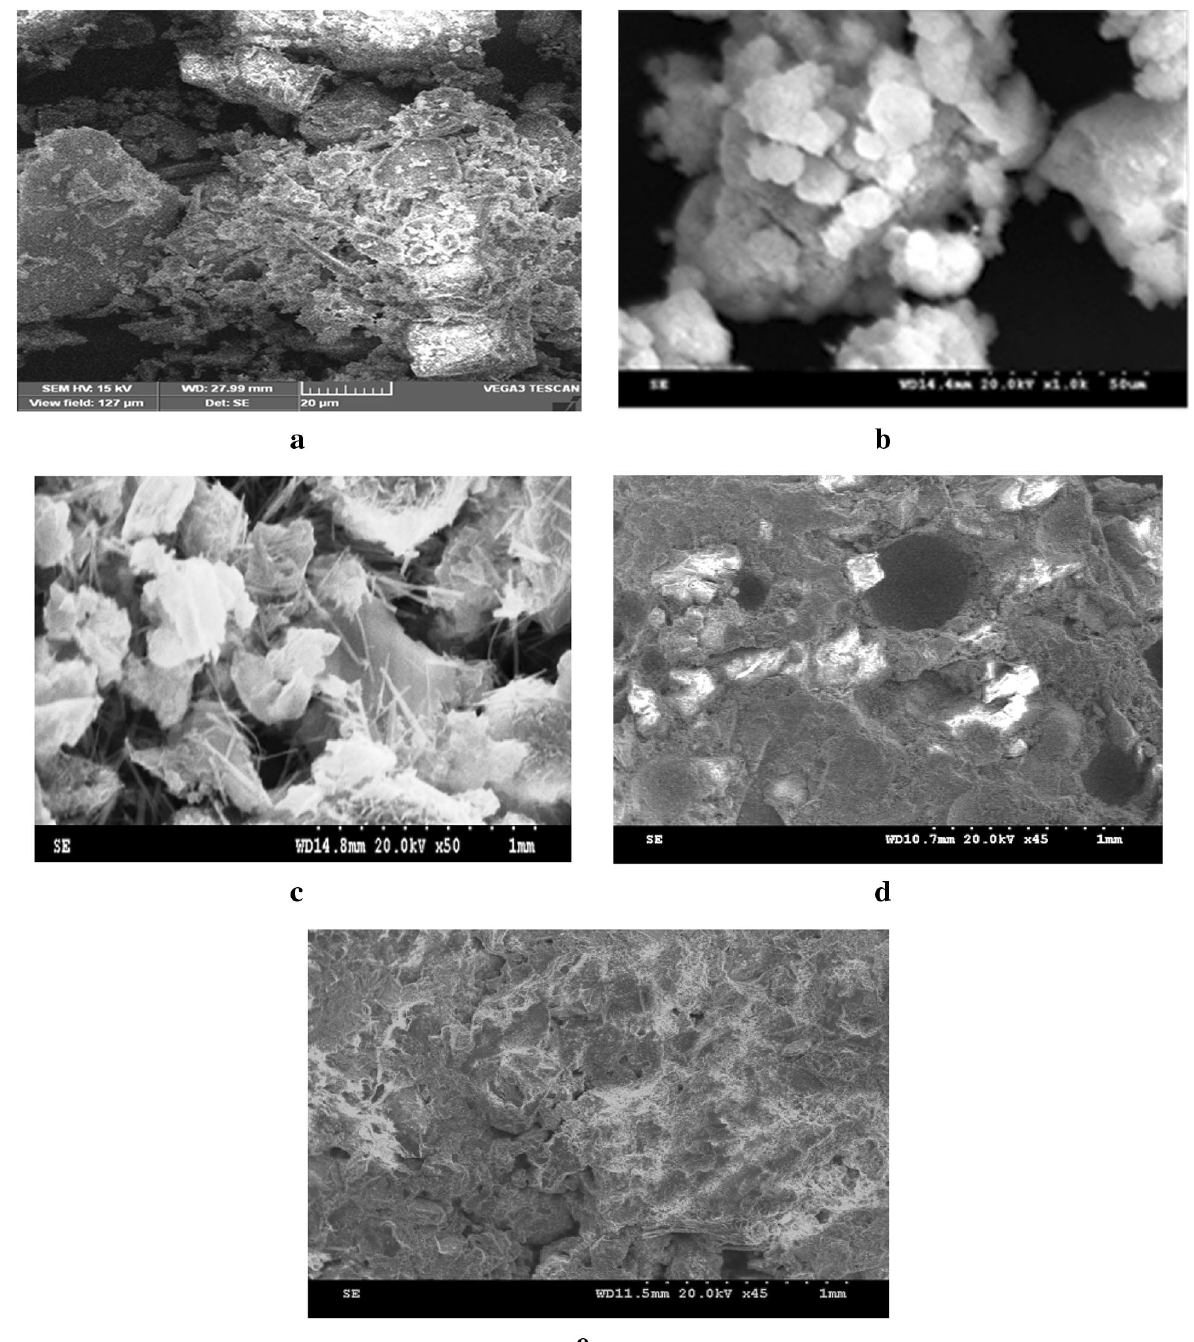
Fig. 2 a Morphology of MP. b Morphology of Nano Fe 2 O 3 . c SEM image of OPC. d SEM image of OPC